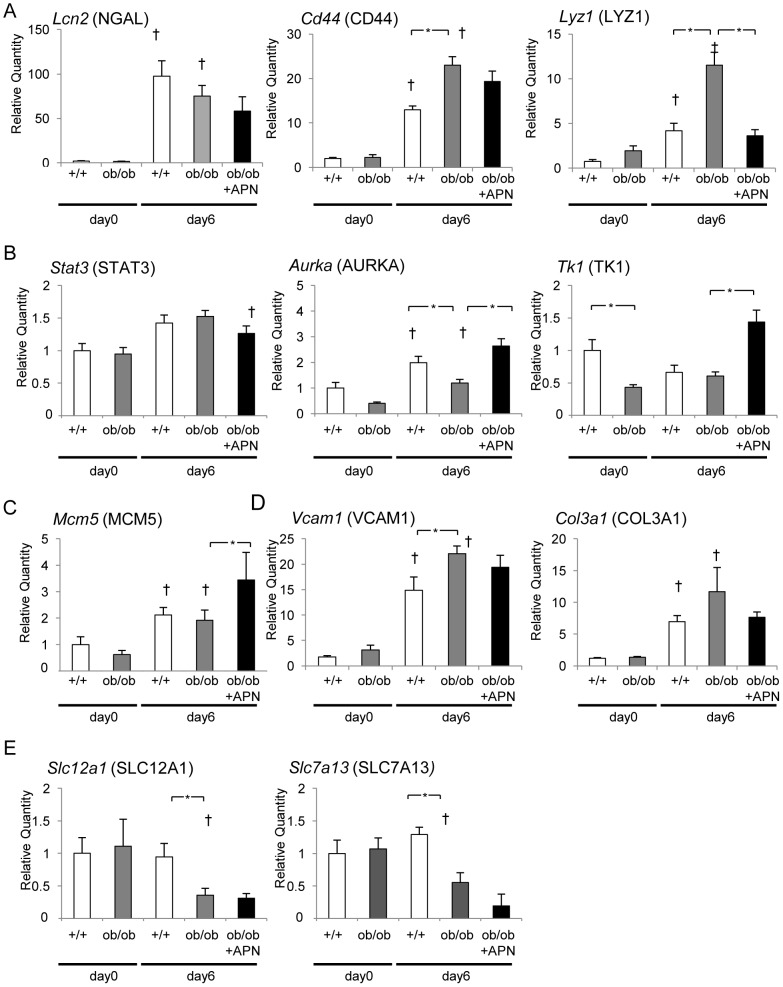
Confirmation that selected genes detected by microarray analysis showed differential expression between different treatment groups.The expression of several characteristic genes belonging to 5 categories based on GO analysis was evaluated by quantitative PCR. Expression levels are expressed relative to Actb. Data are indicated as the mean ± SE. *, p<0.05 between the groups at the same time point. †, p<0.01 compared with the same group at day 0. 5 categories are as follows. A. Inflammation and immune-related gene group: Lcn2, lipocalin2; Cd44, CD44 antigen; Lyz1, lysozyme1. B. Apoptosis-related gene group: Stat3, signal transducer and activator of transcription 3; Aurka, aurora kinase A. C. Cell repair and proliferation-related gene group: Mcm5, minichromosome maintenance deficient 5. D. Adhesion and fibrosis-related gene group: Vcam1, vascular cell adhesion molecule 1; Col3a1, collagen, type III, alpha 1. E. Transporter-related gene group: Slc12a1, solute carrier family 12, member 1; Slc7a13, solute carrier family 7, member 13.